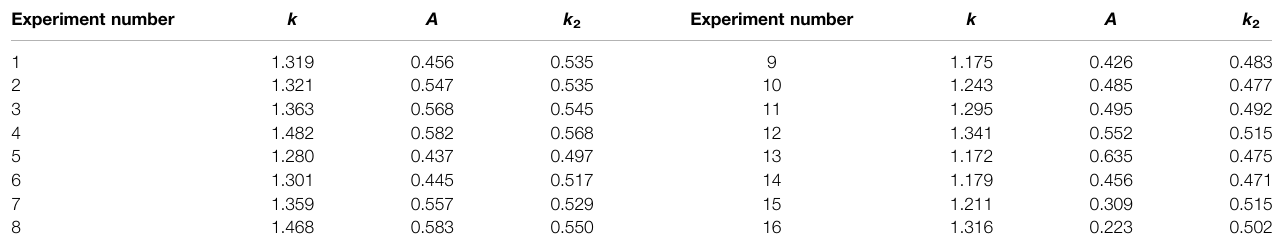
TABLE 6 | Orthogonal experimental results of A , k , and k 2 . Experiment number